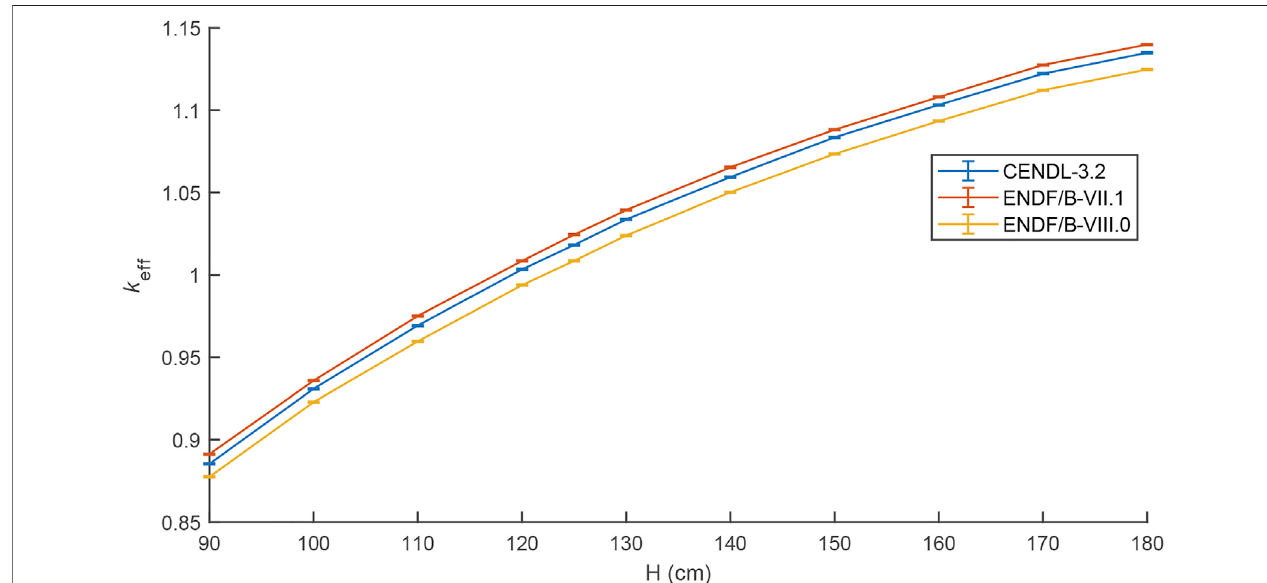
FIGURE 4 | Curve of loading height and k